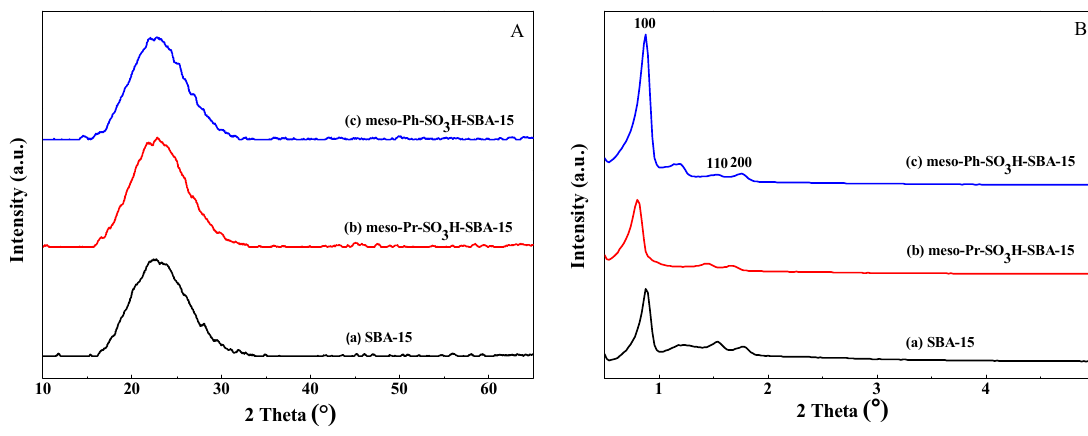
Figure 2. The high-angle ( A ) and low-angle ( B ) XRD patterns of SBA-15 and two modified Figure 2. The high ‐ angle ( A ) and low ‐ angle ( B ) XRD patterns of SBA ‐ 15 and two modified SBA ‐ 15 samples. SBA-15